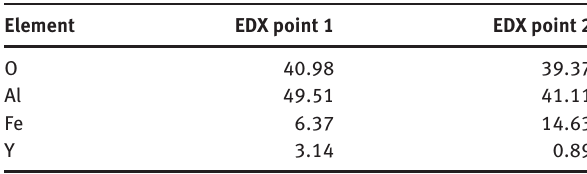
Table 2: Contents of main constituents at various points in Figure 2A